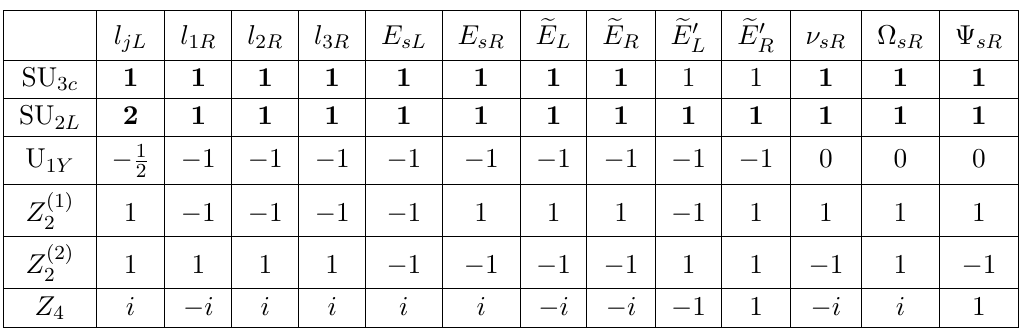
× Z (2) × Z 4 . Here j = 1 , 2 , 3 and 2 2